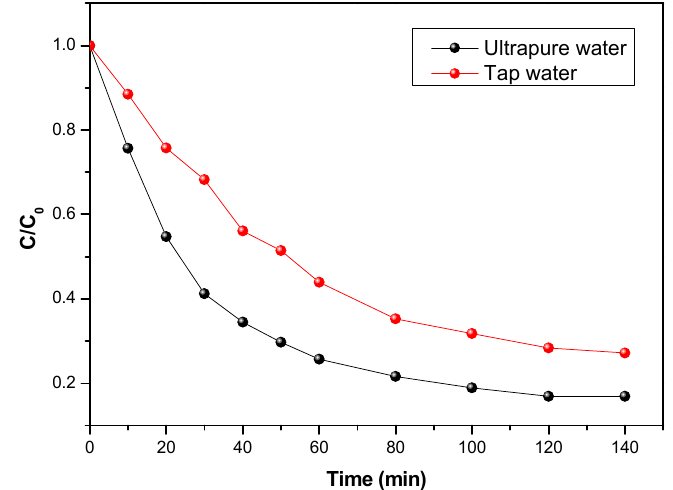
Figure 5. Evolution of the concentration of flumequine: Comparison between tap water and ultrapure water as solvents to induce degradation, with an initial concentration of 5 mg/L, UV 38 W/m 2 , and a flow rate of 126 L/h.